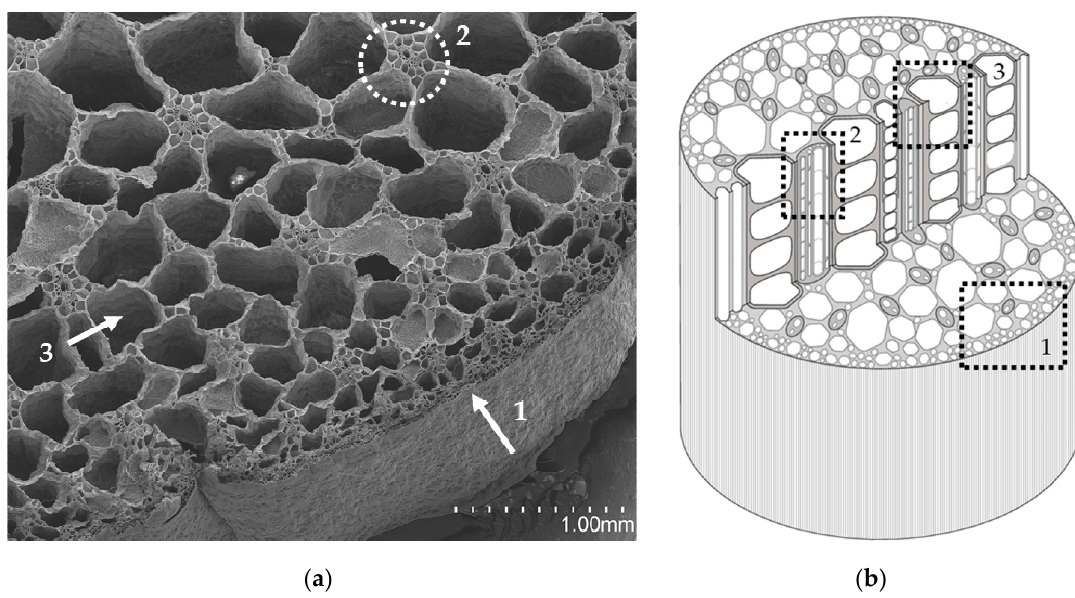
Figure 3. ( a ) General internal structure of the petiole section, SEM view: epidermal cells (1), “fibre unit” (2) and aerenchyma tissue (3); ( b ) General scheme of the petiole section: epidermal cells (1), “fibre unit” (2) and aerenchyma tissue (3).